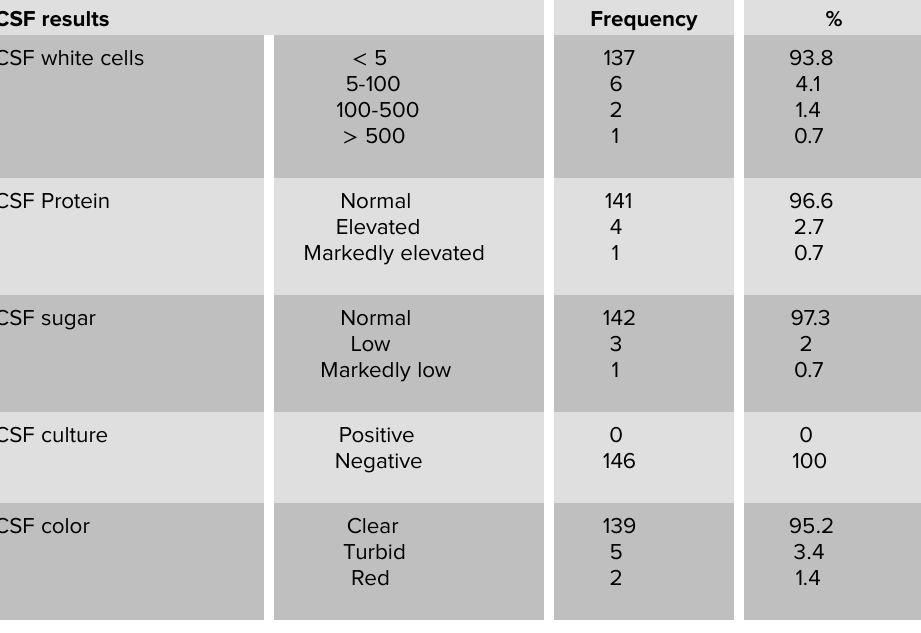
Table 6: Distribution of the study population according to CSF results (n